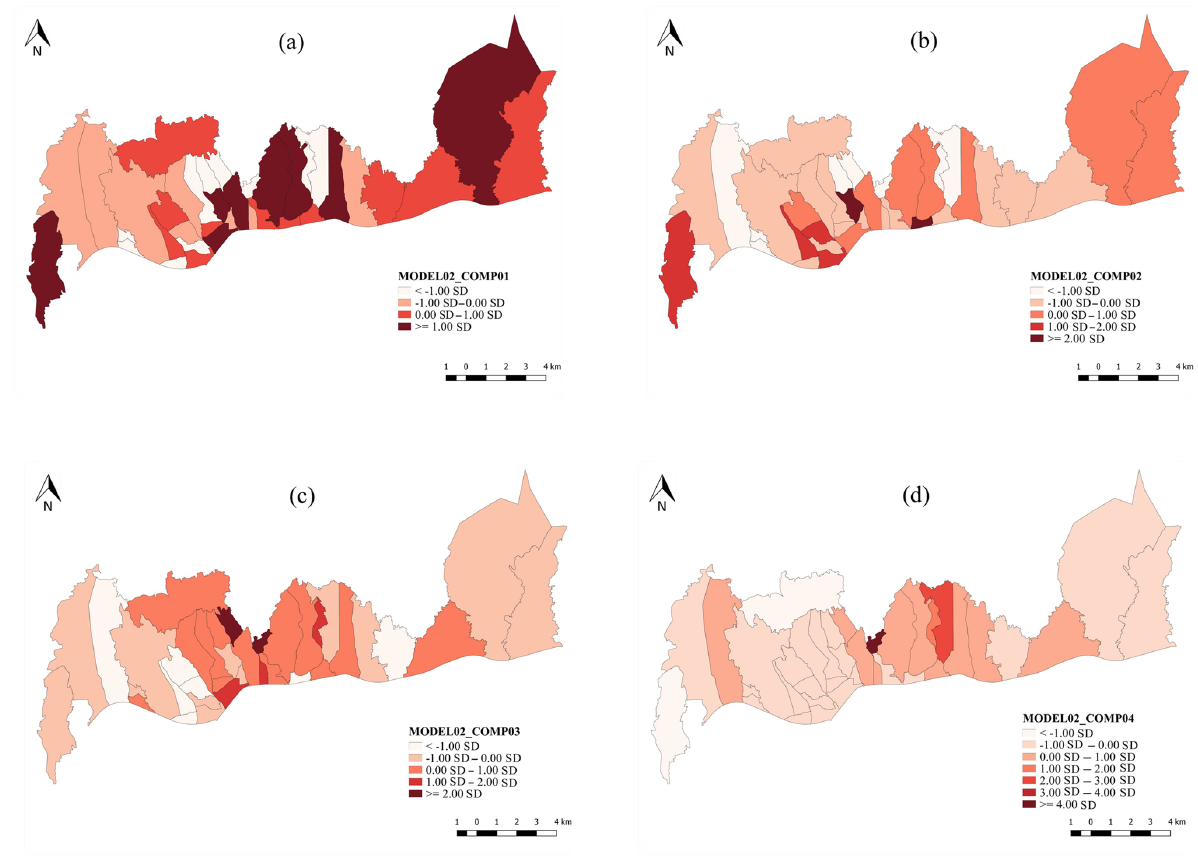
Figure 10. Spatial distribution of Model 2 (new housing development area) Components. (a) Component 1; (b) Component 2; (c) Compo- nent 3; (d) Component